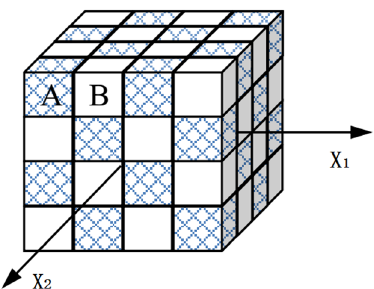
Figure 3. The mesomechanical model of polycrystalline material consisting two kinds of cuboidal elements with different yield stress.